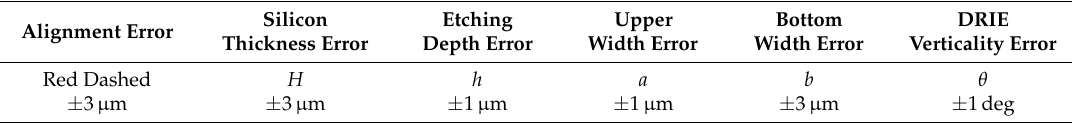
Table 2. The range of fabrication imperfections.